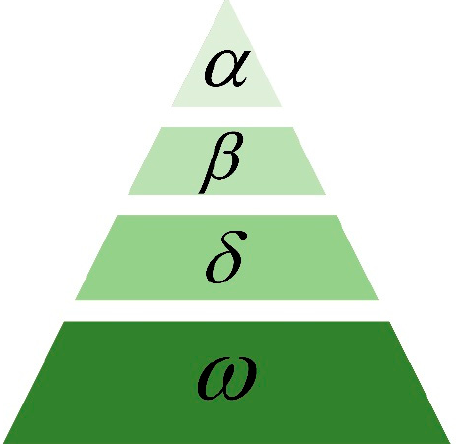
Figure 4. Subdomain adaptation schematic. The three gray wolves closest to the prey are named α , β and δ in order from near to far, corresponding to the optimal solution, the second optimal solution and the third optimal solution of the fitness function respectively; the remaining gray wolves are named uniformly as ω , corresponding to other candidate solutions. α , β and δ guide ω to search for prey, ω update location around α , β and δ . The entire hunting optimization process is shown in Figure 5, which mainly